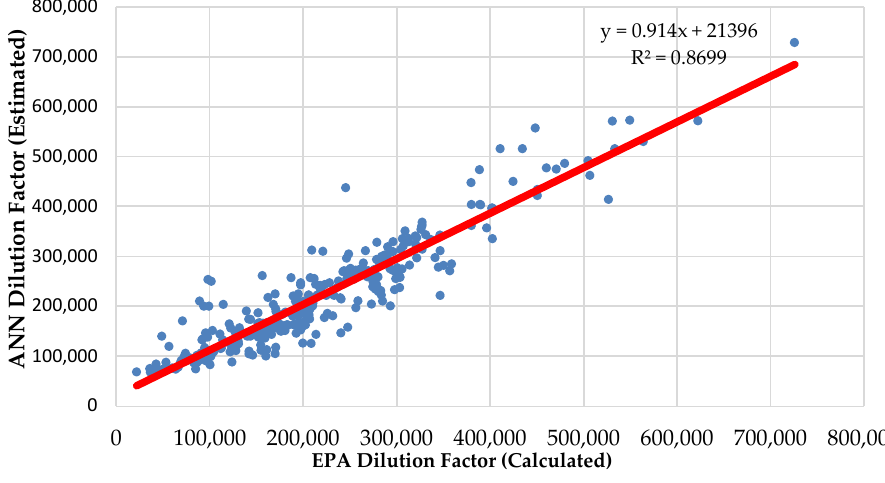
Figure 7. Calculated and estimated dilution factors for both engine power and gross ton inputs ( DF ANN